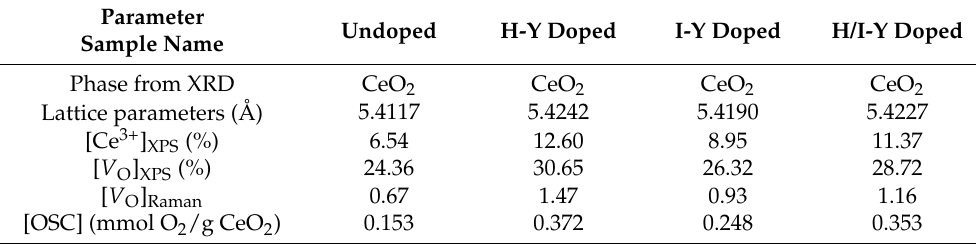
Table 1. Phase, lattice parameters, [Ce 3+ ] XPS , [ V O ] XPS , [ V O ] Raman , and [OSC] of Undoped and H-Y-, I-Y-, and H/I-Y-doped CeO 2